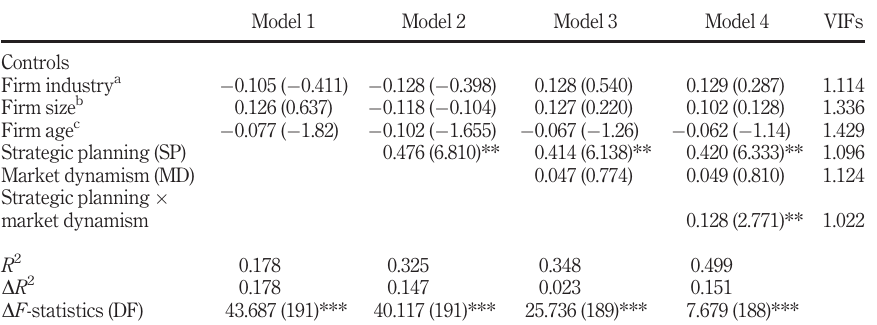
Table IV. Regression